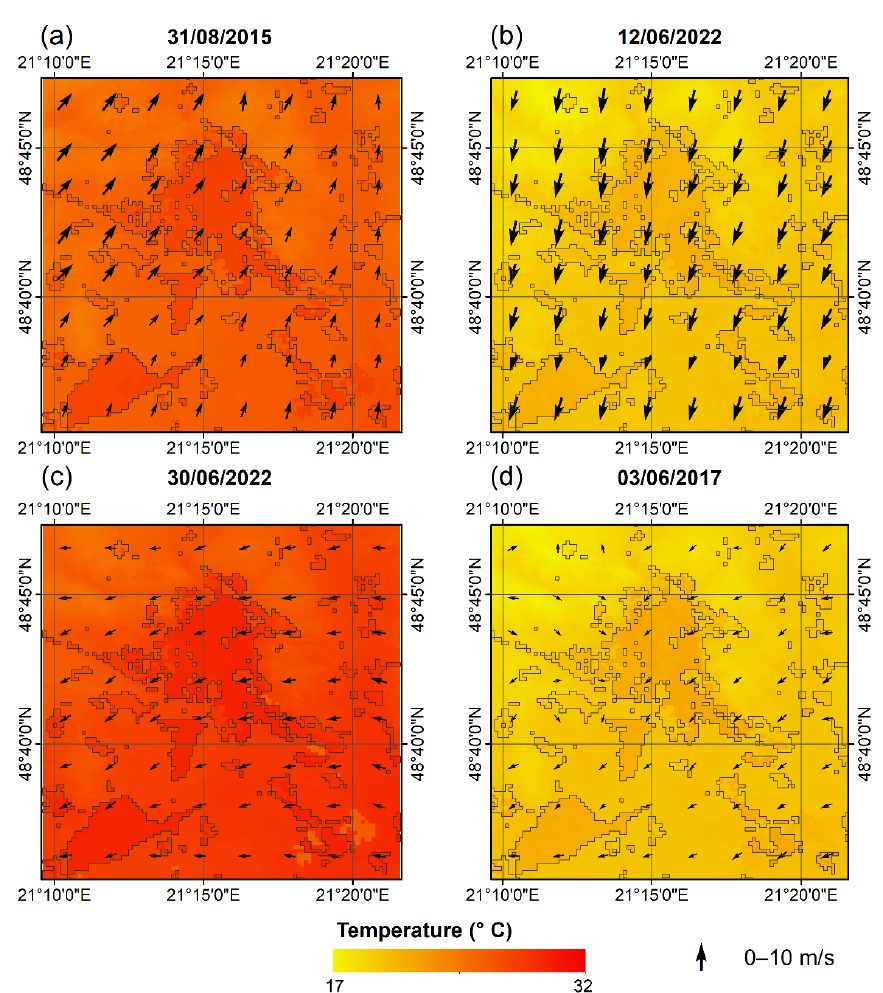
Figure 6. The average temperature at 2 m and average 10 m wind vectors from the third model domain (D3) with marked built-up areas during the ( a ) warm dynamic situation of 31 August 2015, ( b ) cold dynamic situation of 12 June 2022, ( c ) warm non-dynamic situation of 30 June 2022 and ( d ) cold non-dynamic situation of 3 June